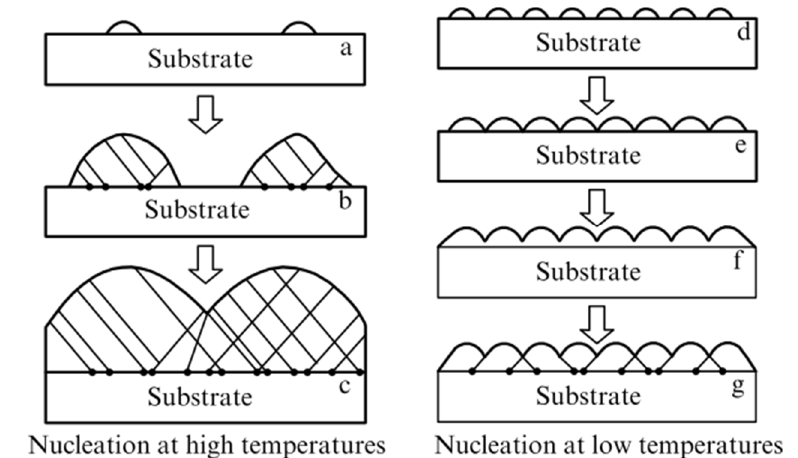
Figure 10. Two ways of introducing misfit dislocations at high-temperature (HT) and low-temperature (LT). Left: Misfit dislocations (MDs) are introduced before the islands coalesce. Right: MDs are introduced after the islands become continuous pseudomorphic film. Reprinted with permission from Reference [25] © Uspekhi Fizicheskikh Nauk 2008.